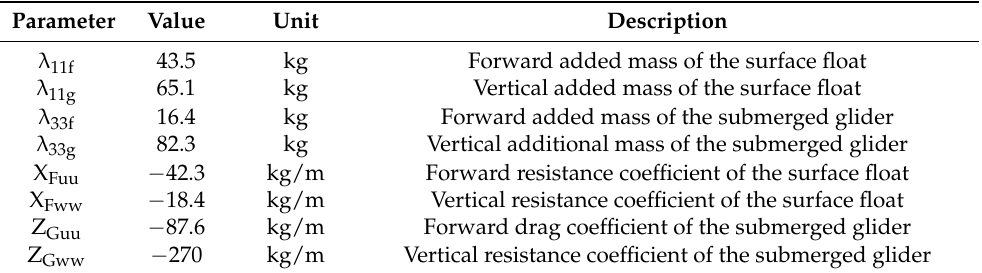
Table 2. Dynamic parameters of the “Black Pearl” wave glider.